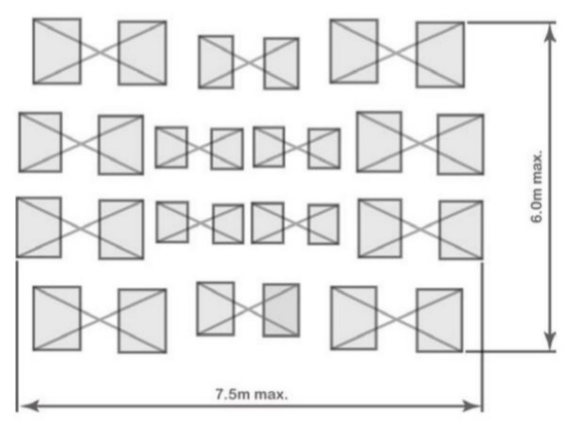
Figure A1. Sensitivity in different parts of the FOV [69].